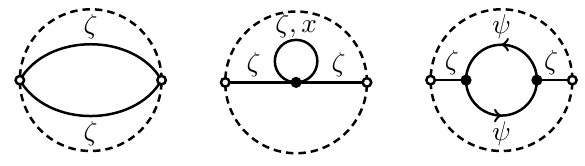
Figure 3 . Diagrams contributing the 2-point function h Y Y i at order 1